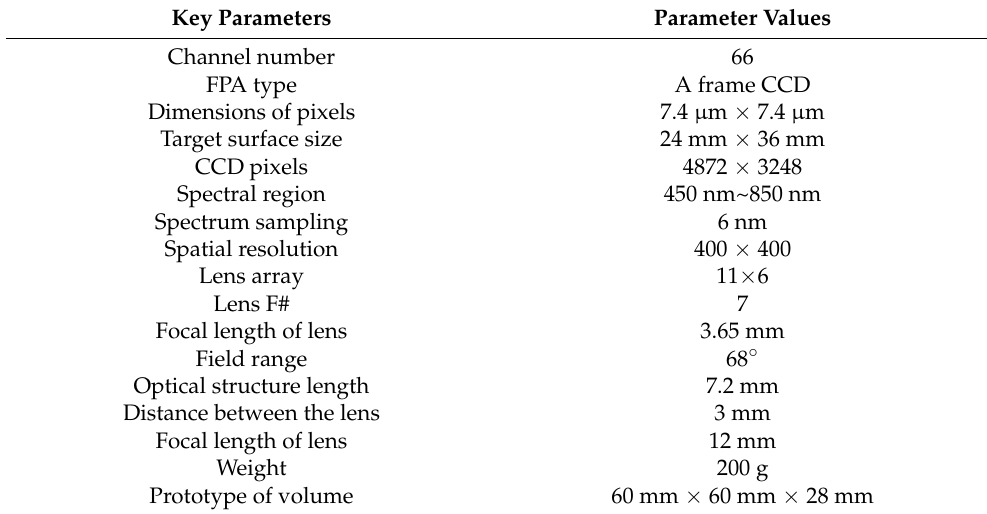
Table 7. Specifications of the